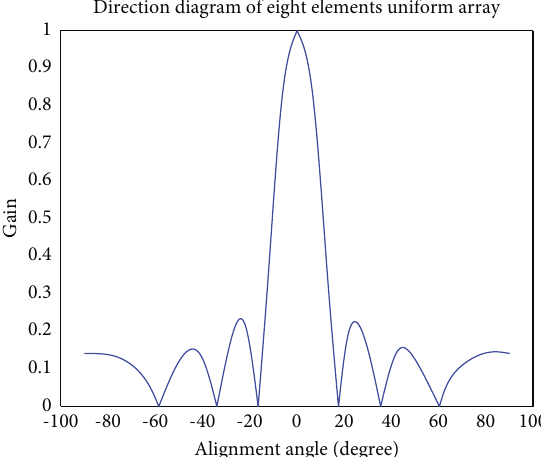
Figure 3: Directional diagram of 8-element uniform linear array.